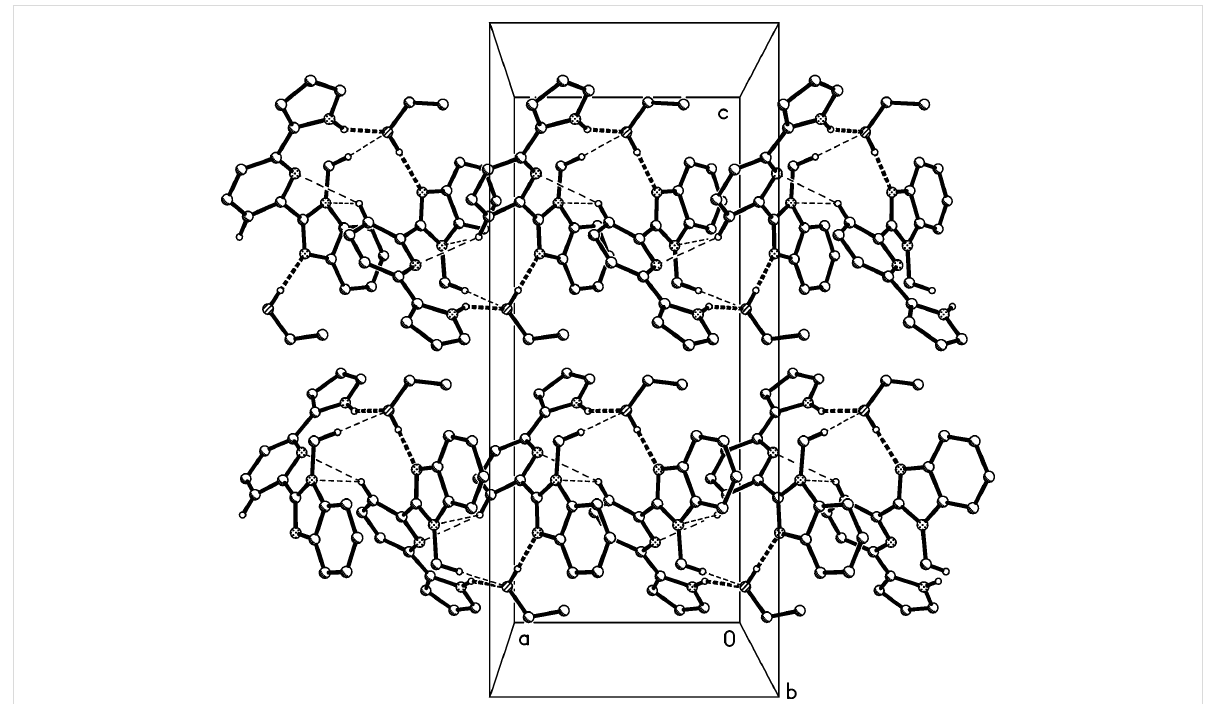
Figure 6: Packing diagram of compound 3 ·C 2 H 5 OH. Hydrogen bonds are shown as thick dashed lines. Hydrogen atoms not involved in the hydrogen bonds are omitted for clarity. Hydrogen bond details (Å,°) for N1–H01 … O99: H … O 2.01(2), N … O 2.848(1), N–H … O 154(1), operator − 1/2 + x , y , 1/2 − z .